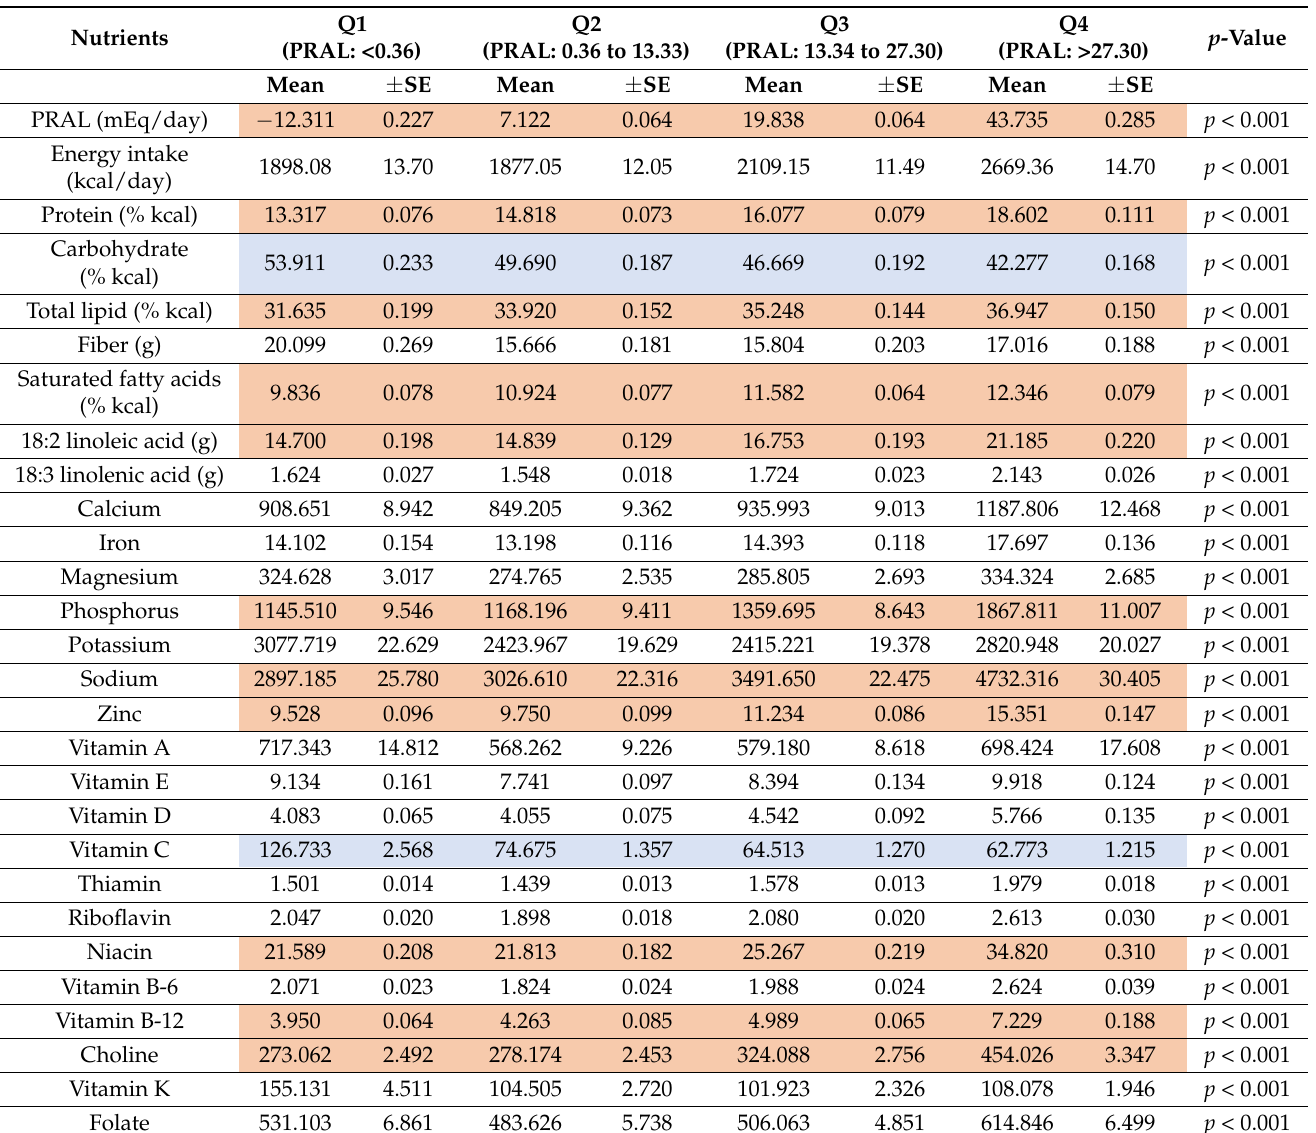
Table 10. Nutrient intake across PRAL-quartiles: an